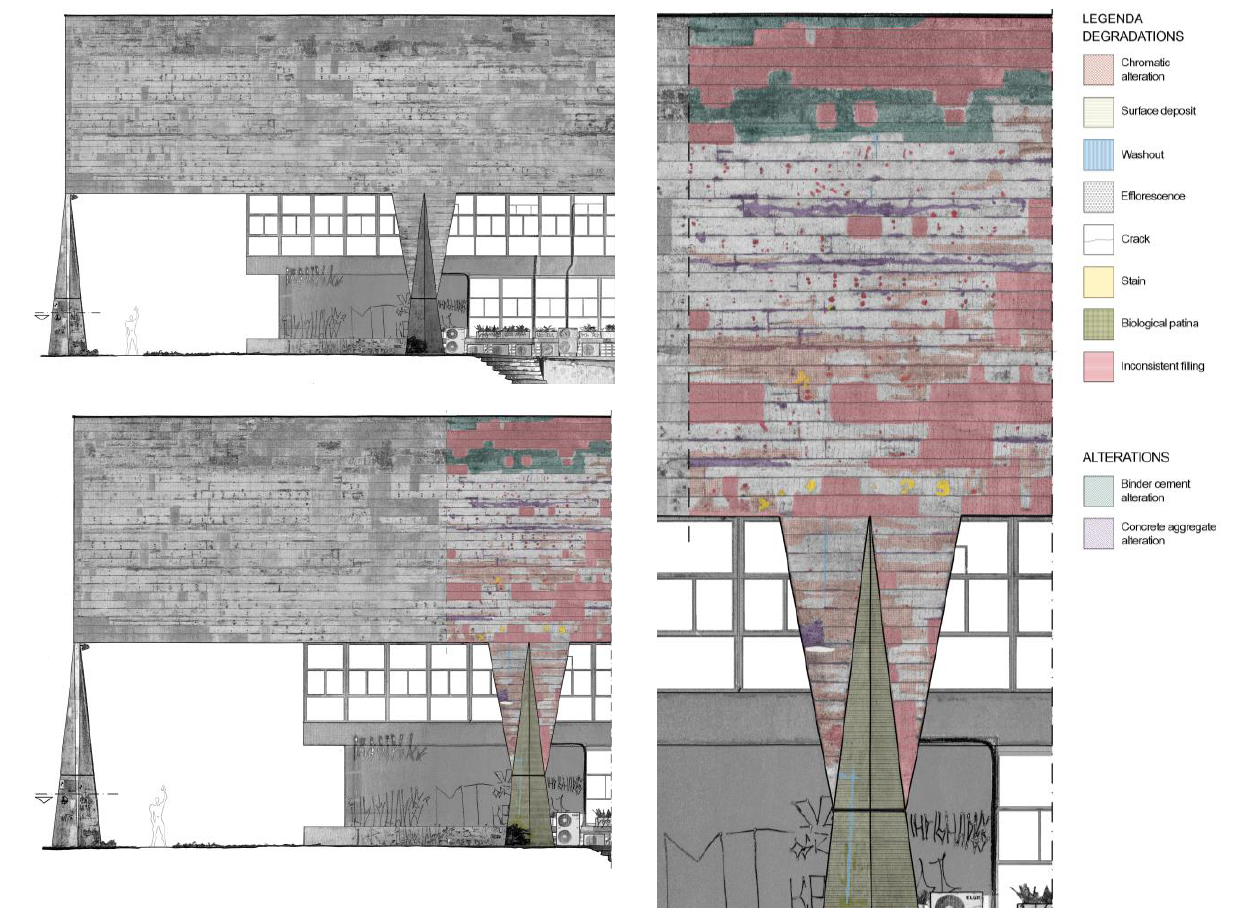
Figure 6. Data representation of a sample of elevation; above, view of the CAD two-dimensional representation superimposed to the DEM; below, example of degradation characterization